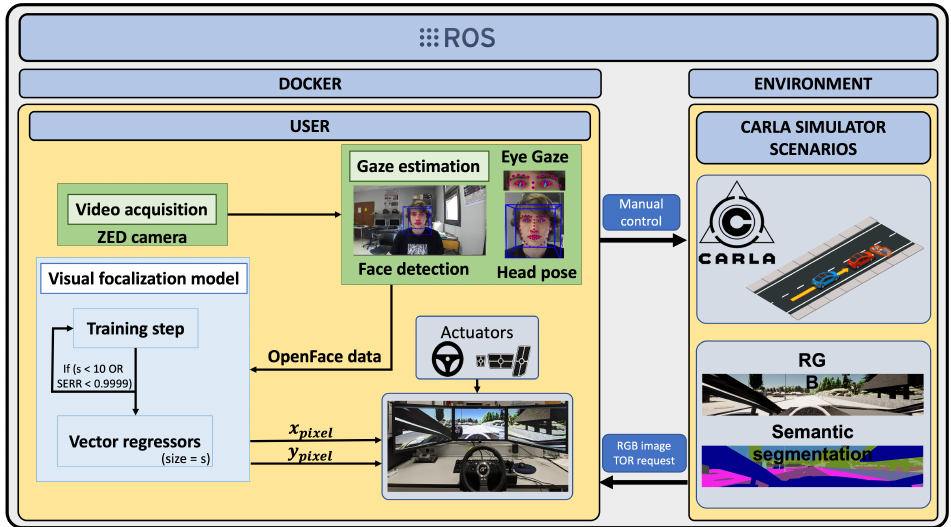
Figure 3. Framework proposed to analyse take-over request (TOR). Green boxes determine the first subsystem/computer and blue boxes the second